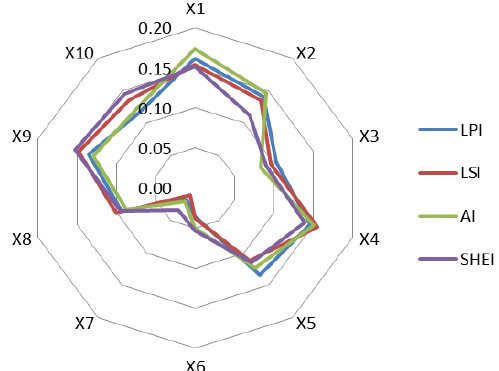
Figure 8. The q -value radar map of factors driving landscape pattern evolution in Yujiang District. X1: elevation; X2: slope gradient; X3: slope direction; X4: gross regional product; X5: population density; X6: average annual temperature; X7: average annual rainfall; X8: Distance from major railways; X9: Distance from major highways; X10: Distance from major waterways. LPI: largest patch index; LSI: landscape shape index; AI: aggregation index; SHEI: Shannon evenness index.